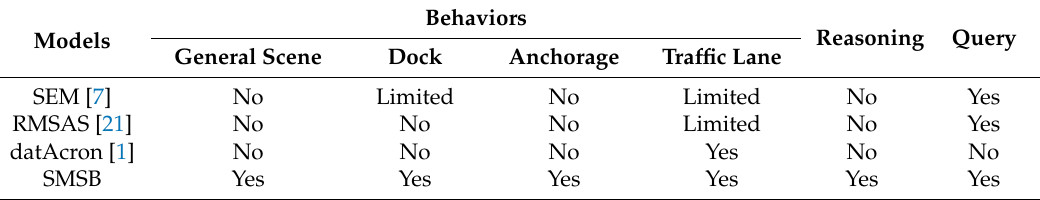
Table 6. Comparison of existing models with our model. Yes means the model includes the corresponding function; limited means the model includes partial corresponding function; and no means the model does not include the corresponding function. Behaviors Reasoning Query Models General Scene Dock Anchorage Traffic